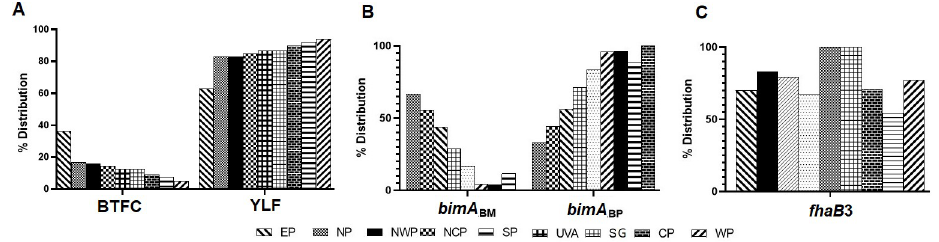
Fig 3. A. Distribution of genotypes of Burkholderia pseudomallei in 9 provinces in Sri Lanka. A. Yersinia- like fimbrial (YLF) and B . thailandensis -like flagellum and chemotaxis (BTFC) gene clusters, B. Burkholderia intracellular motility factor A ( bimA ), C. Filamentous hemagglutinin 3 ( fhaB3 ). WP-Western Province, SP-Southern Province, BM bimA Bp Eastern Province, NP-Northern Province, NWP-North Western Province, SGP-Sabaragamuwa Province, CP-Central Province, NCP-North Central